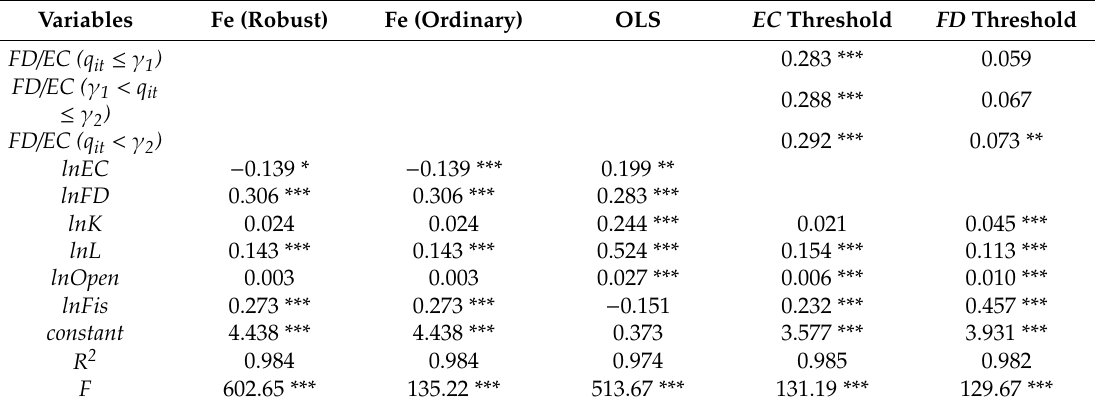
Table 3. Estimation results of panel